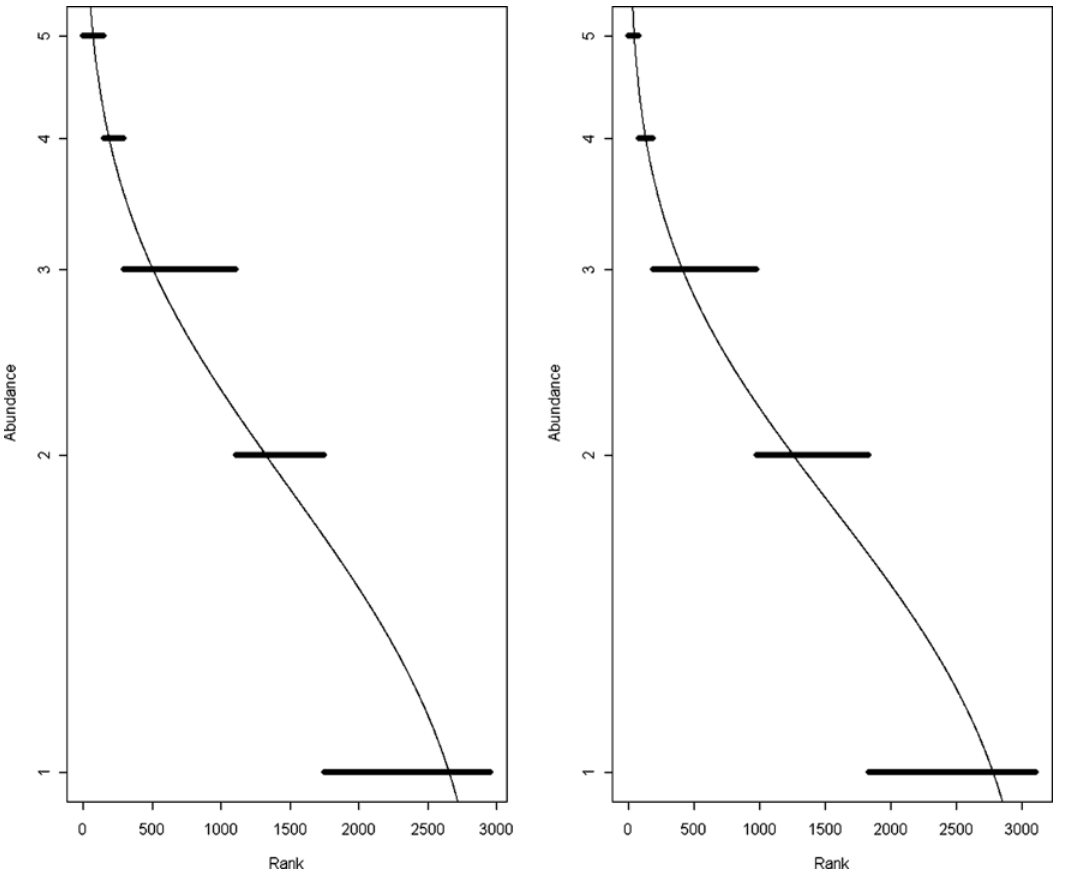
Figure 3. Dominance–diversity curves for both sampling dates (1966 and 1996). These plots display logarithmic species abundances against species rank order in the community [56].